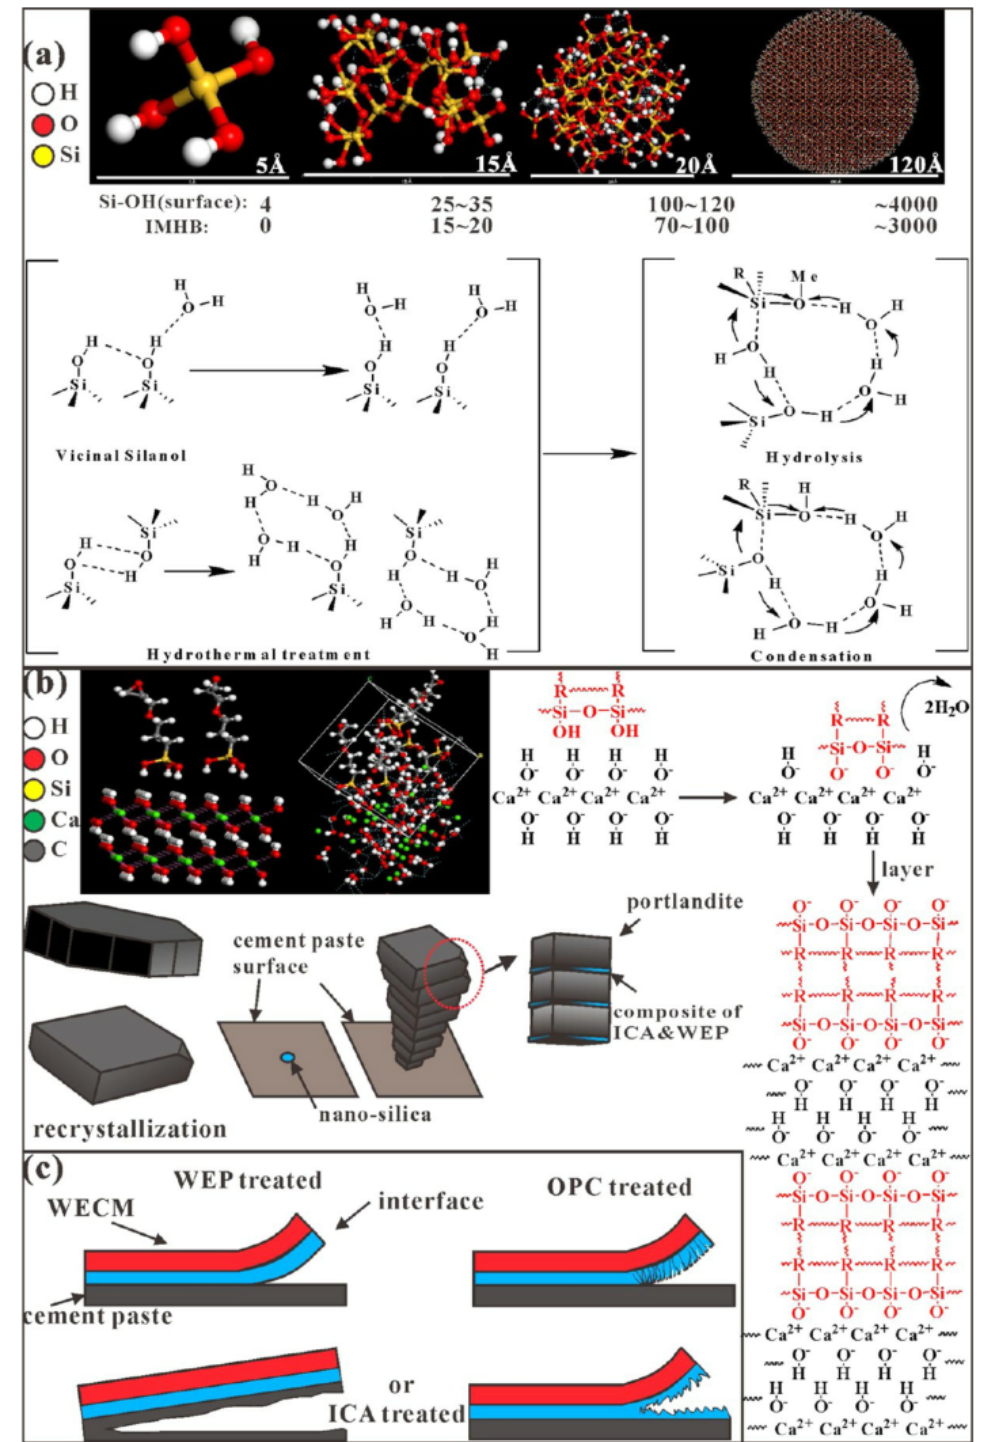
Figure 18. Nano-silica-modified silane as an interfacial coupling agent between epoxy-modified mortar and concrete structure: ( a ) Mechanism of the catalytic effect of hydrothermally treated nano-silica on SCA hydrolysis and condensation, ( b ) fine-grained effect and interfacial coupling effect of SCA on portlandite, ( c ) damage schematic of the interface treated by different means [72]. (Adapted and reprinted with permission from ref. 72, © 2018, ACS Applied Materials & Interfaces .).